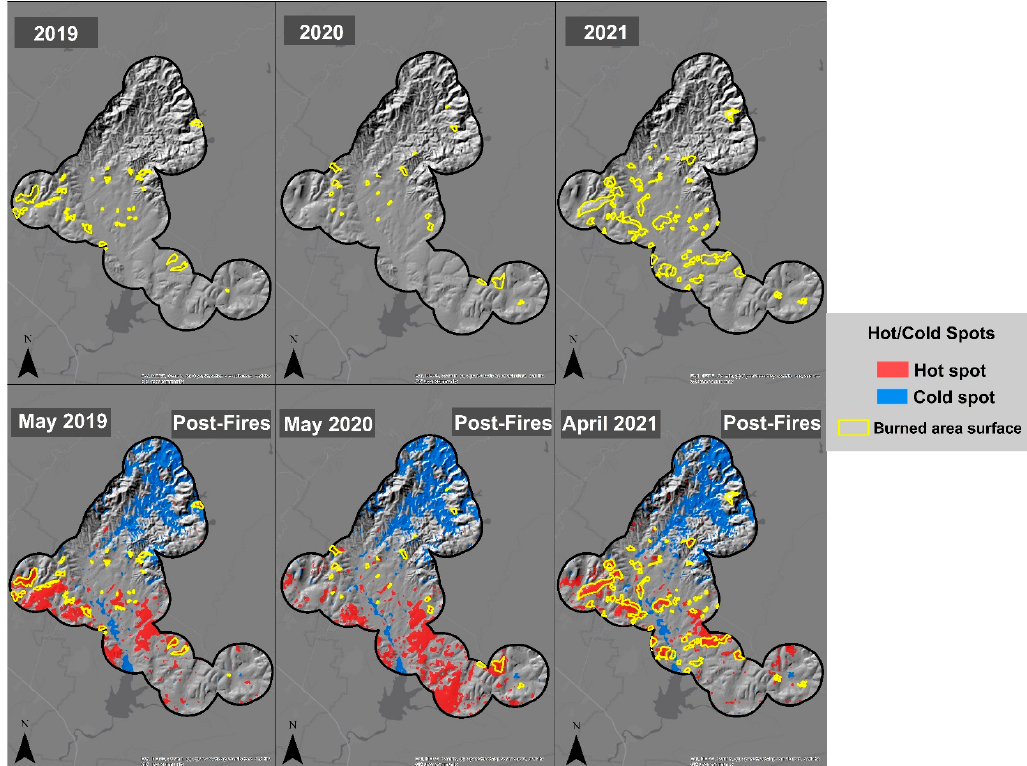
Figure 5. Maps of burned areas for the post-fire years ( top ) and hot and cold spots for post-fire (2019, 2020, and 2021) seasons and burned areas ( bottom ). The mean LST of the unburned areas for the years 2019, 2020 and 2021 is 37 °C, 38 °C, and 37 °C, respectively, while the burned areas presented a mean LST of 47 °C, 43 °C, and 39 °C (Figure 6). LST significantly differs between the unburned and burned areas, showing the significant impact of wildfires on the increase in LST in the burned areas compared to the unburned areas. As for the Shapiro–Wilk normality test and the Bartlett test of homogeneity of variances, the results of both tests show a normal distribution and homogeneity of variance, respectively, with p -values greater than 0.5.